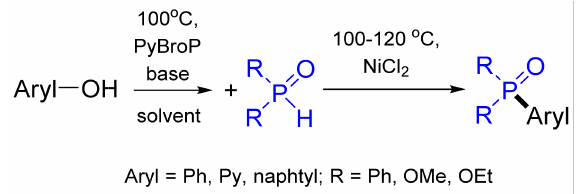
Figure 34. Hirao reaction after activating the hydroxyl group of phenols.